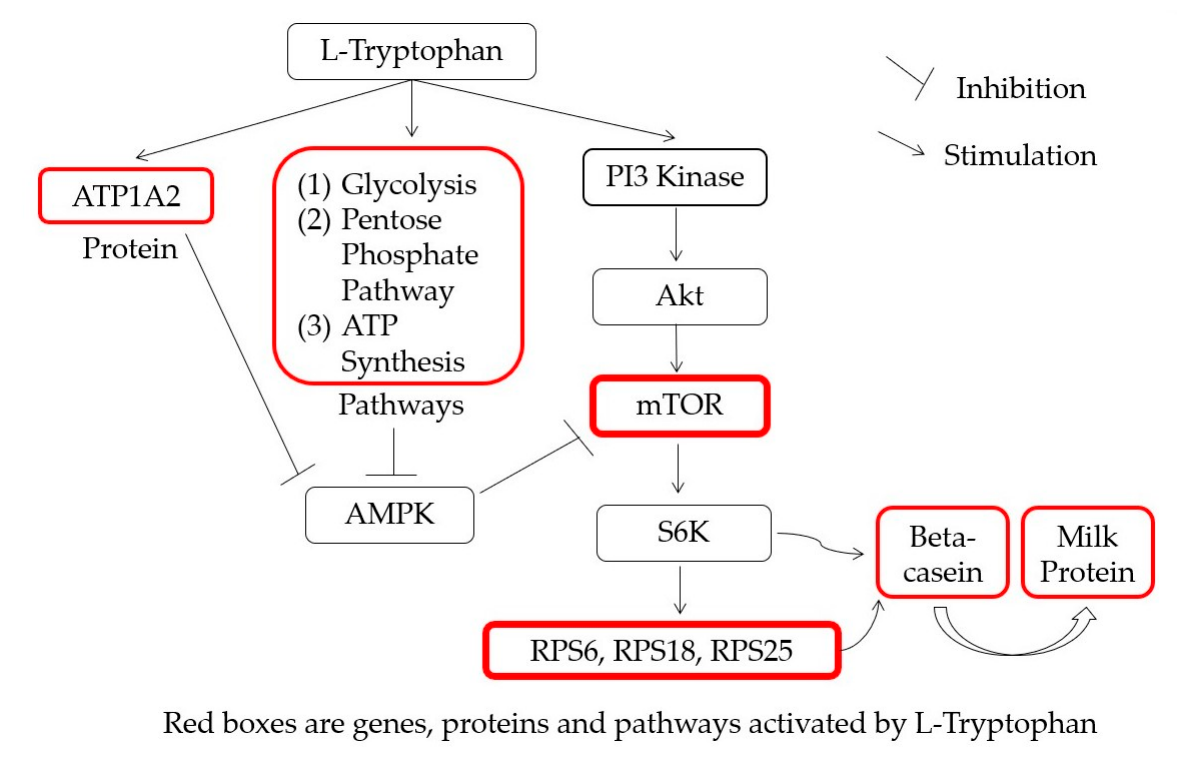
Figure 4. Diagram of the effect of L-Trp supplementation on milk protein synthesis pathways. ATP1A2, ATP1A2 sodium/